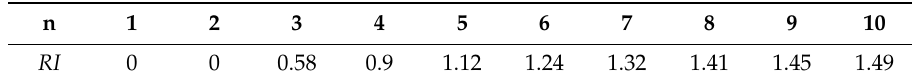
Table 2. The random consistency index (RI)